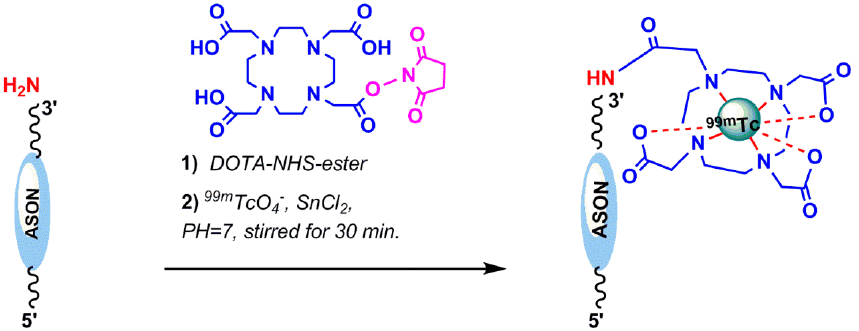
Figure 7. Conjugation of the Tetraazacyclododecane tetraacetic acid (DOTA)–NHS–ester to amine ‐ functionalized oligonucleotide for 99m Tc radiolabeling.